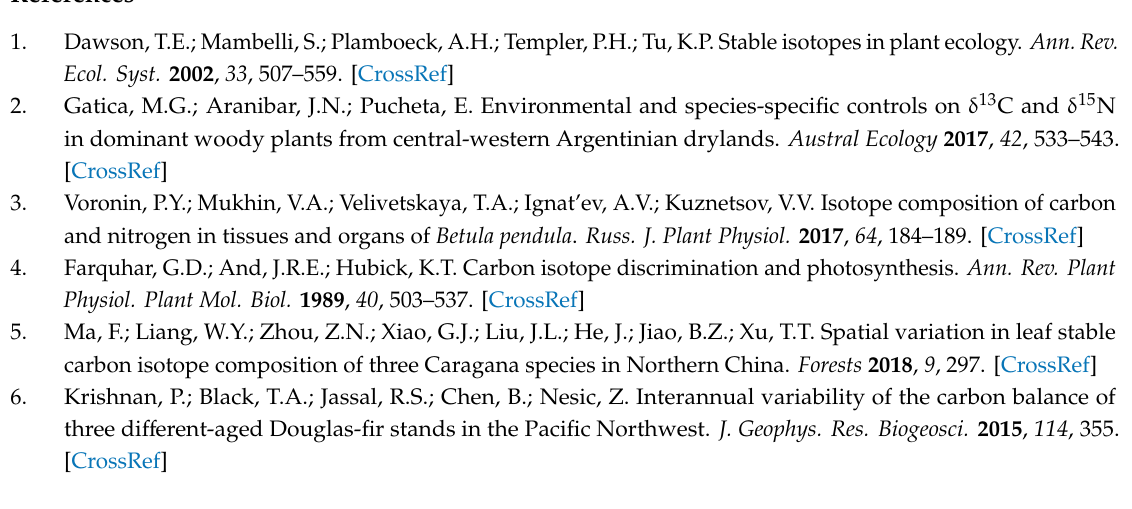
Figure S1: Di ff erences in leaf N concentrations (A) and leaf P concentrations (B) between four years’ leaves (from current-year-old and up to 3-year-old) collected along di ff erent tree ages levels. Di ff erent uppercase letters represent significant di ff erences among leaf ages at each tree age level, while di ff erent lowercase letters represent significant di ff erences among tree ages at each leaf age